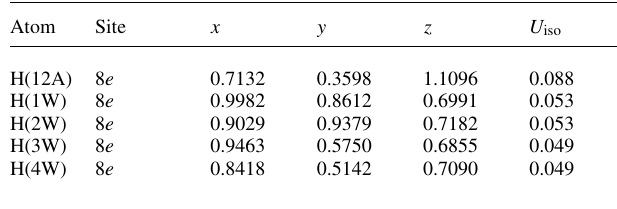
Table 2. Atomic coordinates and displacement parameters (in Å 2 )